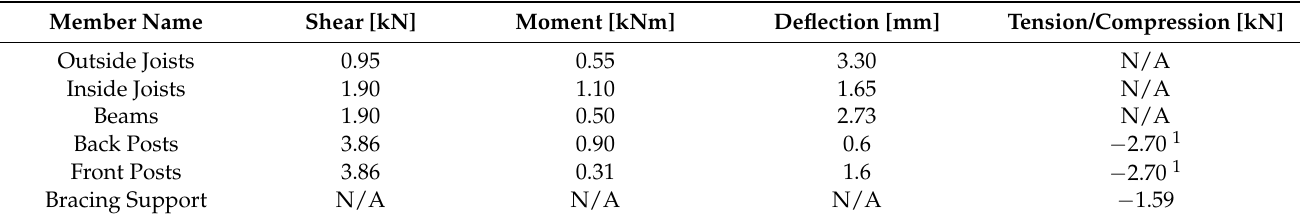
Table 4. Forces and deflections of structural members in the fixed angle rack.